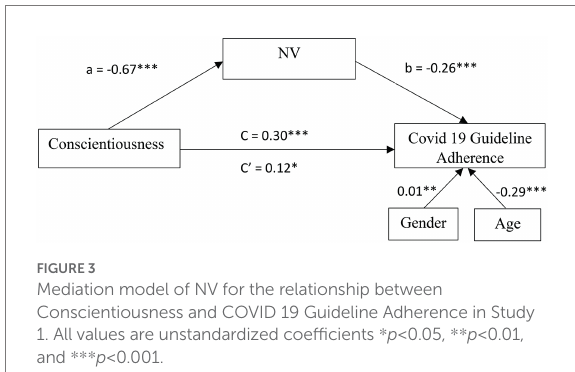
FIGURE 3 Mediation model of NV for the relationship between Conscientiousness and COVID 19 Guideline Adherence in Study 1. All values are unstandardized coefficients * p < 0.05, ** p < 0.01, and *** p <